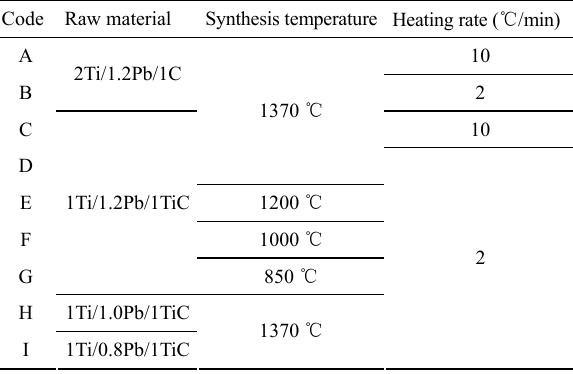
Table 1 Compositions of r w materials and synthesis C e Heating rate ( ℃